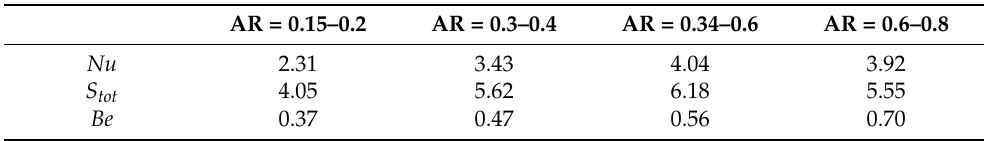
Table 5. Mid Nu, total EGE, and Be for Ra = 10 5 , Rd = 1, Ha = 20, γ = 45, ω = 0, ϕ = 0.03, and different aspect